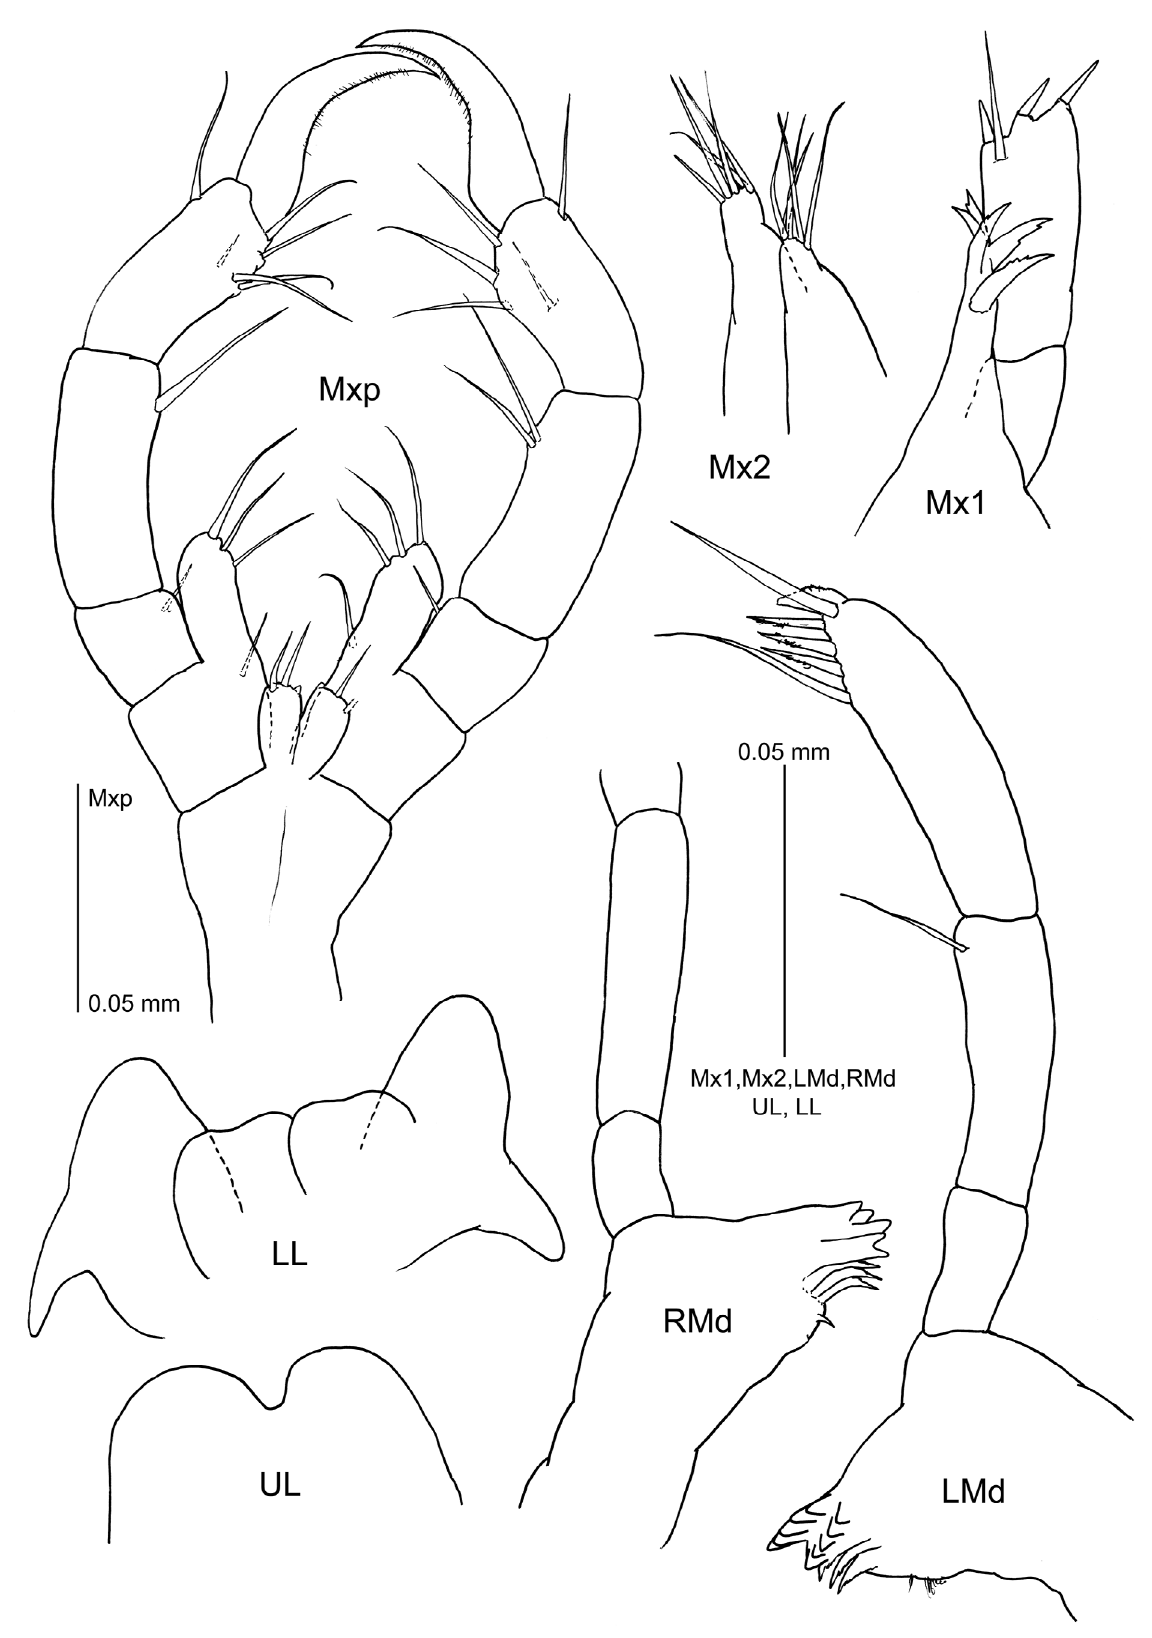
Figure 3. Parapseudaeginella australiensis n. sp. Mouthparts of holotype male (WAM C76110). Abbreviations: UU = Upper lip; LMd = Left mandible; RMd = Right mandible; LL = Lower lip; Mx 1, 2 = Maxilla 1, 2; Mxp =